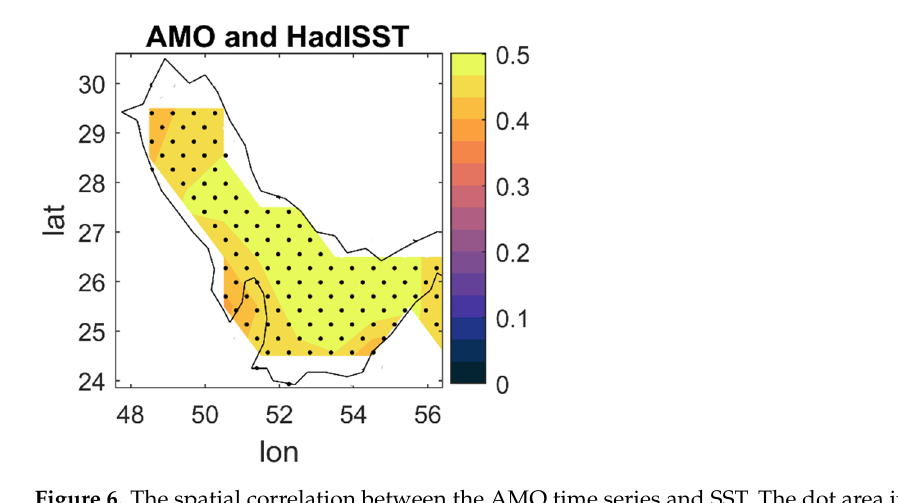
Figure 6. The spatial correlation between the AMO time series and SST. The dot area indicates the significant area at 95%.